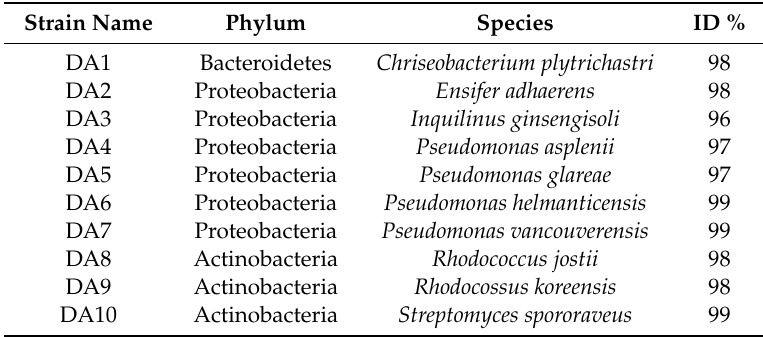
Table 1. Phylogenetic affiliation by 16S r-DNA sequencing of the bacterial strains co-occurring in the sampled biofilm. The strains have been named with the abbreviation DA followed by a progressive number.